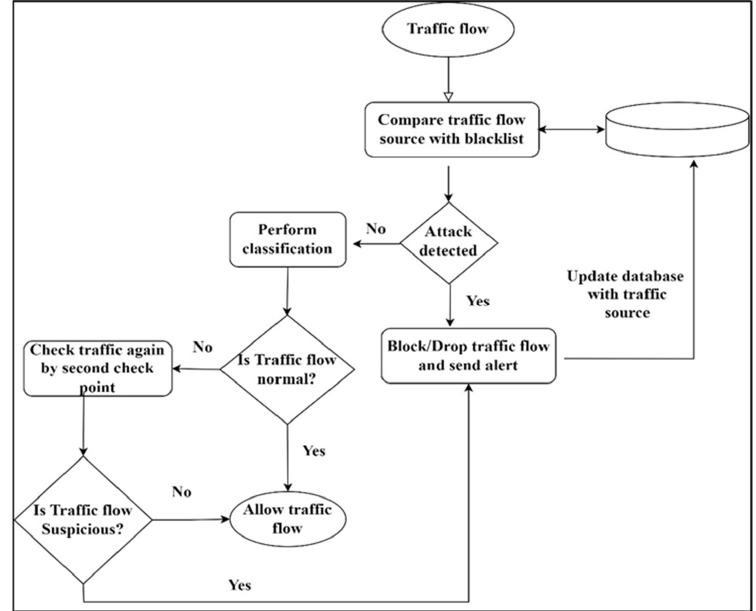
Figure 11. The operational flow chart of the proposed framework.